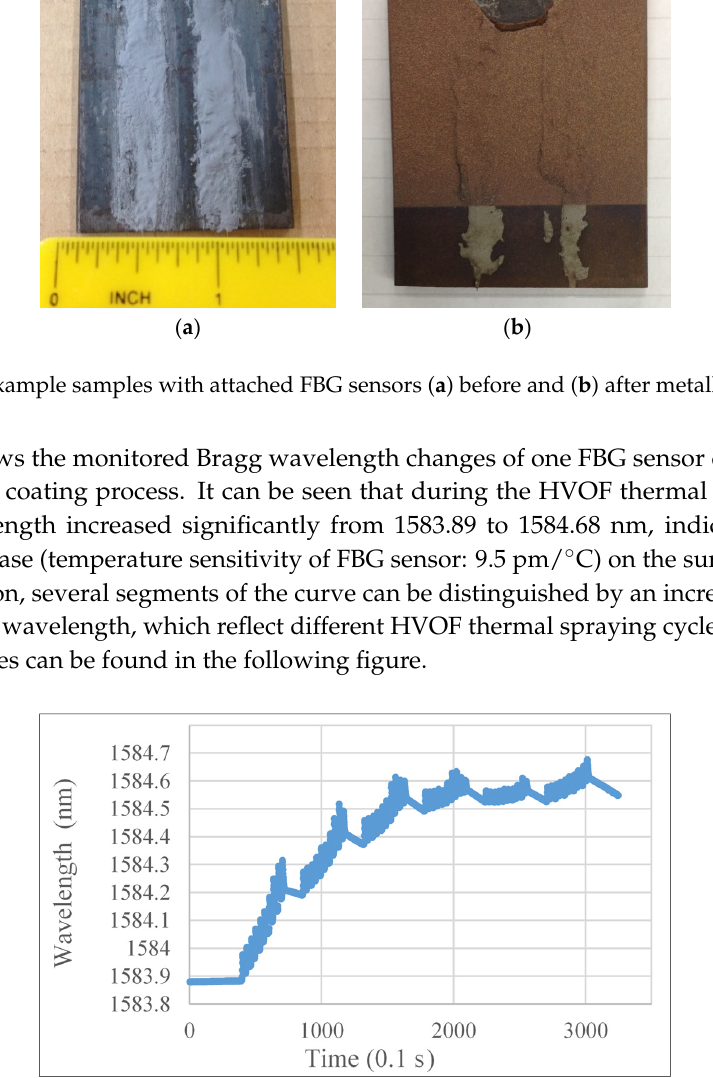
Figure 7. Monitored Bragg wavelength changes of a FBG sensor during thermal spraying coating process.